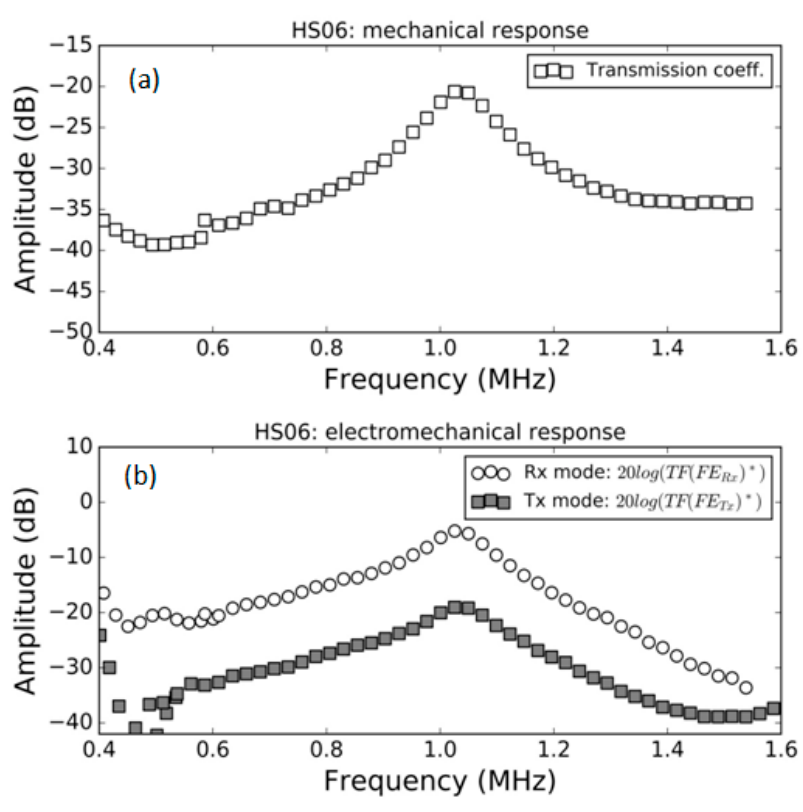
Figure 7. Measured response of the HS06 FE sample in air. ( a ) Modulus of the transmission coefficient vs. frequency; ( b ) electromechanical response vs. frequency both in Tx and Rx mode, (see Equations (16) and (22)).